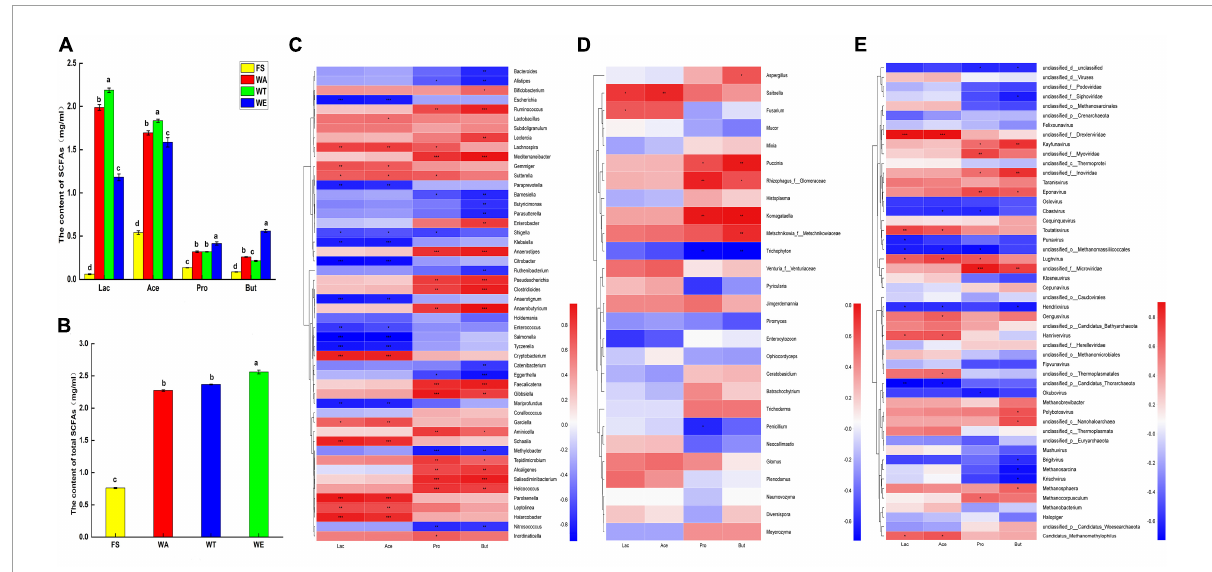
FIGURE2 The content of acetate, propionate, butyrate and lactate in different samples after fermentation and Spearman correlation heat map of species and metabolites in cereals mixture; (A) Four organic acids in each group content; (B) Total content of SCFAs. Letters represent the significance ( P < 0.05) of single metabolite differences in different samples. (C) Correlation of bacteria at genus level with lactate, acetate, propionate, butyrate; (D) Correlation of fungi at genus level with lactate, acetate, propionate, butyrate; (E) Correlation of virus at genus level with lactate, acetate, propionate, butyrate; color intensity is proportional to the relative abundance of the genus. Correlation coefficients are represented by colors. Dark red indicates positive correlation and dark blue indicates negative correlation. P values calculated using Spearman’s rank correlation test, ∗ P < 0.05; ∗∗ P < 0.01; ∗∗∗ P <